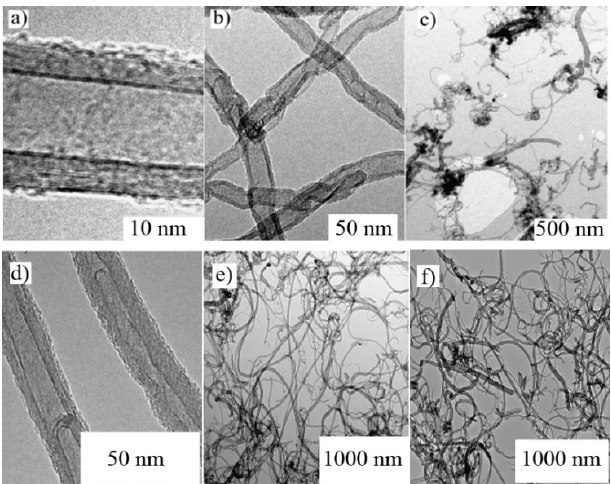
Figure 2. The upper set: Transmission electron microscopy micrographs of MWCNT(Sun)s. ( a ) The structure of an individual pristine nanotube, ( b ) the detail of a nanotube crossing, ( c ) the cluster of pristine nanotubes. The lower set: TEM micrographs of MWCNT(Bayer)s. ( d ) The structure of an individual pristine nanotube, ( e ) the cluster of pristine nanotubes, ( f ) the cluster of oxidized MWCNT(Bayer)KMnO 4 .